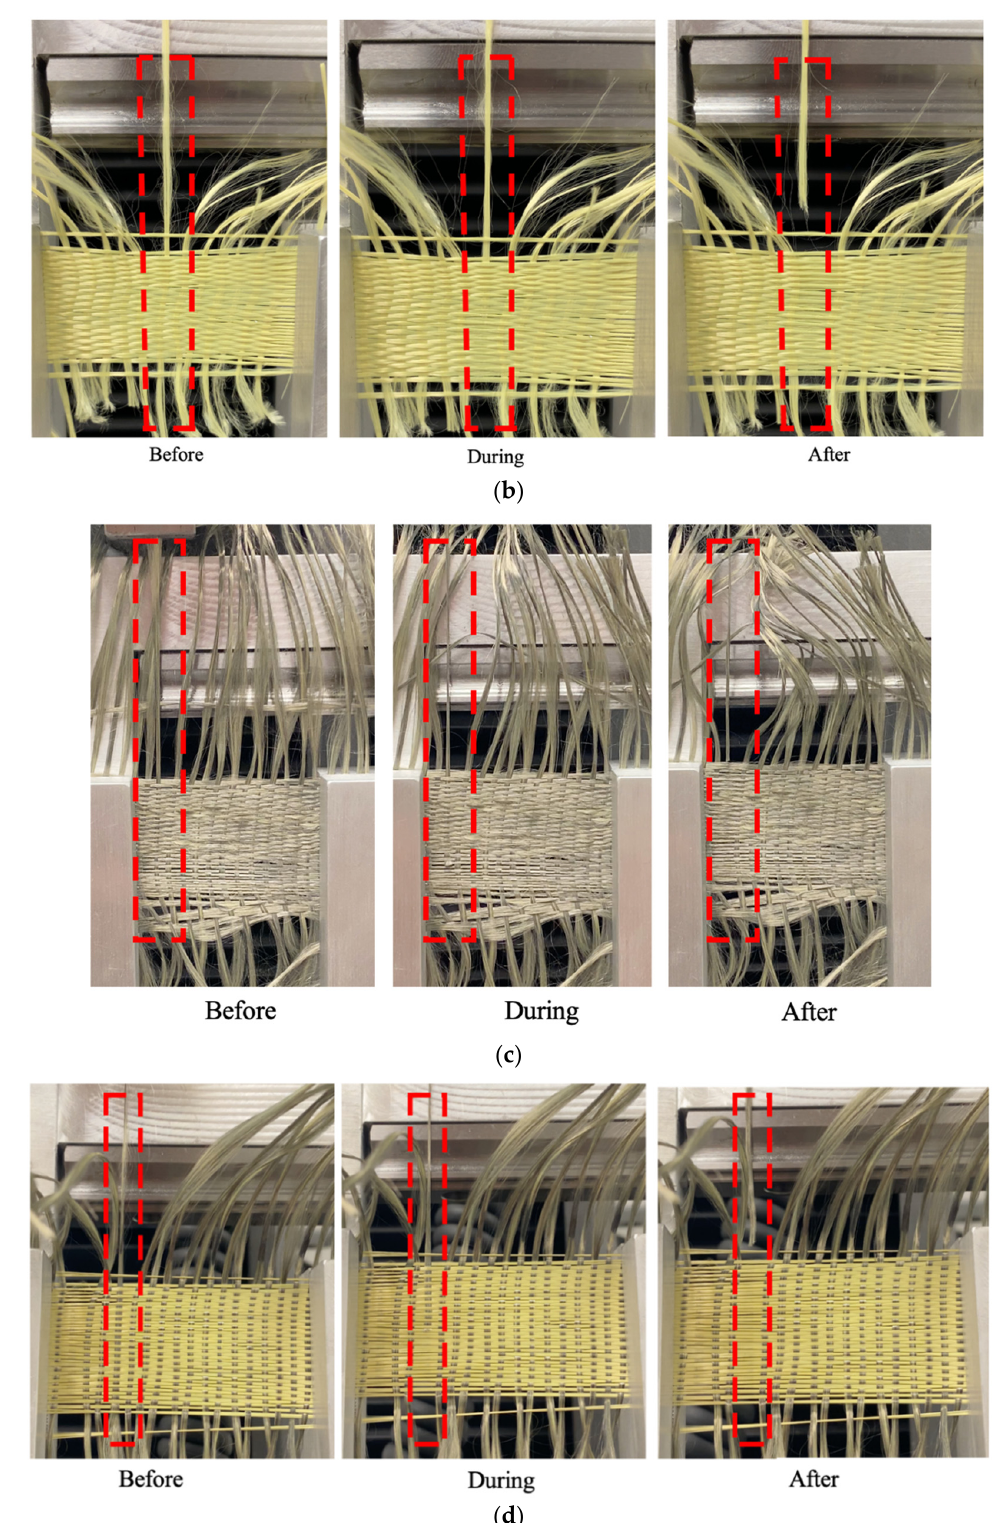
Figure 8. Pull ‐ out process at 400 N transverse pre ‐ tension with pulled yarn highlighted in a box ( a ) Figure 8. Pull-out process at 400 N transverse pre-tension with pulled yarn highlighted in a box ( a ) As ‐ received ( b ) Control ( c ) Al/AlN ( d ) Hybrid Al/Control. As-received ( b ) Control ( c ) Al/AlN ( d ) Hybrid